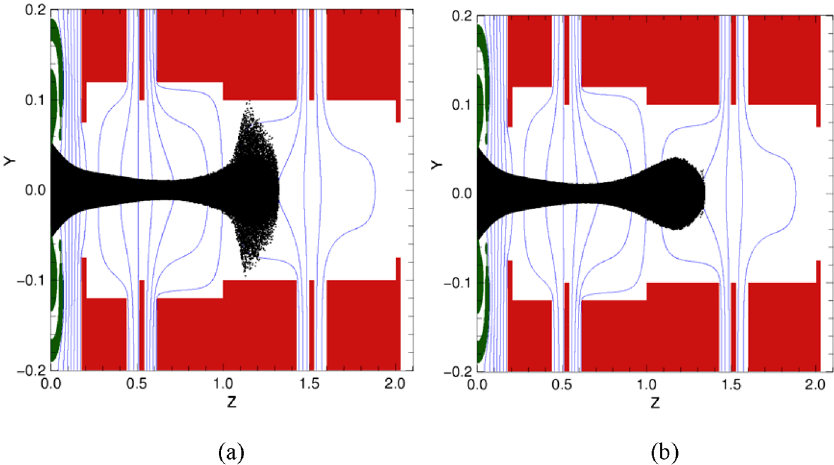
FIG. 17. (Color) Results from a time-dependent 3D PIC simulation showing the behavior of the head of the beam pulse according to the extraction voltage rise time. (a) Vertical shape of the beam head using the measured rise time of the voltage pulse, showing scraping of the beam on the ESQ electrodes. (b) Vertical shape of the beam head with rise time reduced by a factor of 2, showing a more confined beam